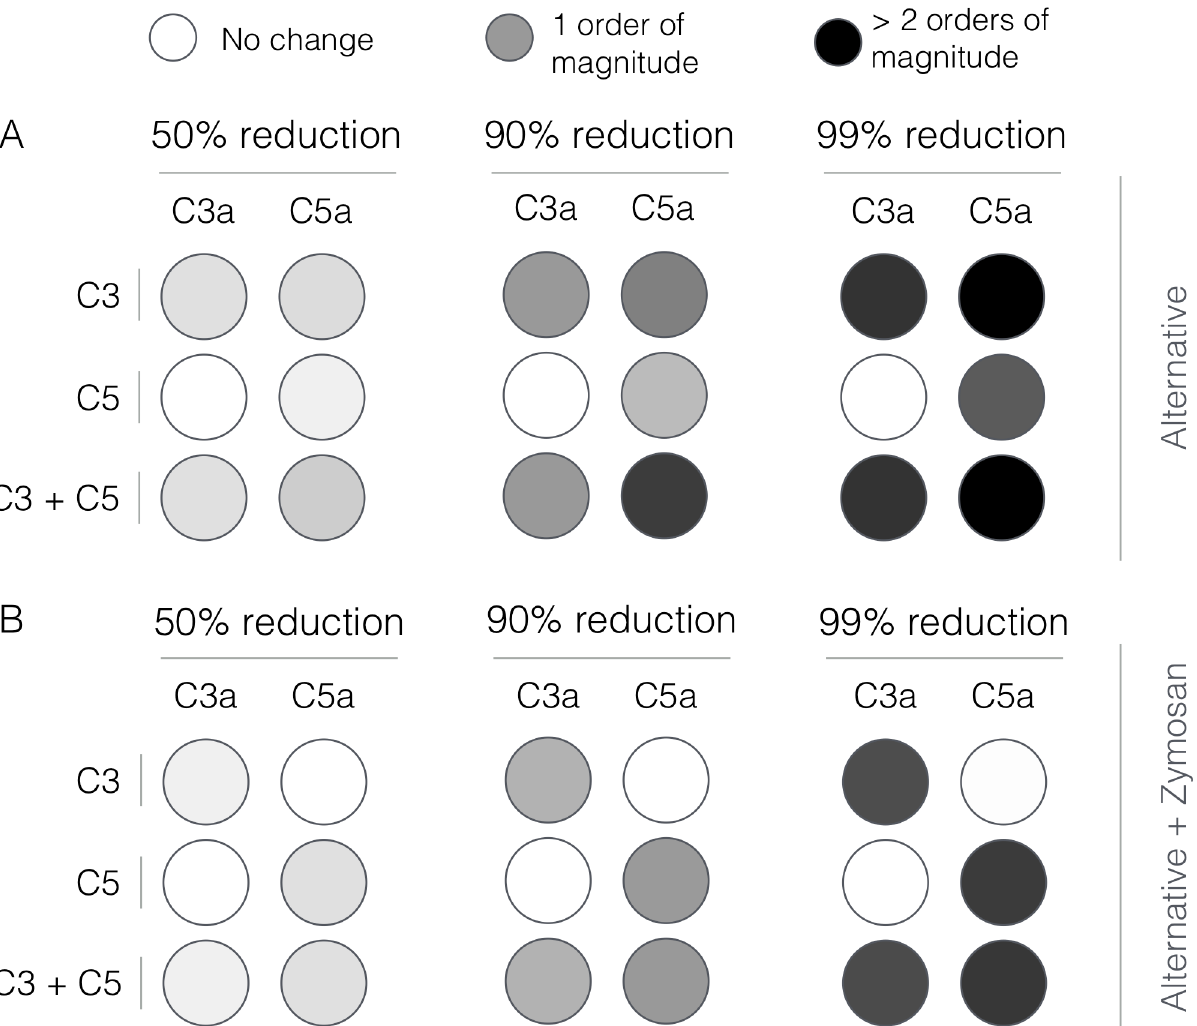
Fig 6. Robustness analysis of the complement model. Robustnesscoefficients were calculatedfor a 50%, 90% and 99% reduction in C3, C5, or C3 and C5 initial conditions. A : Mean robustness index for C3a and C5a generated in the absenceof zymosan. B : Mean robustness index for C3a and C5a generatedin the presenceof 1 mg/ml zymosan. The color describesthe degreeof reductionof C3a or C5a following the network perturbation. Robustnesscoefficients were calculatedusing all parameter sets with Pareto rank less than five (N = 65). Mean robustness values were